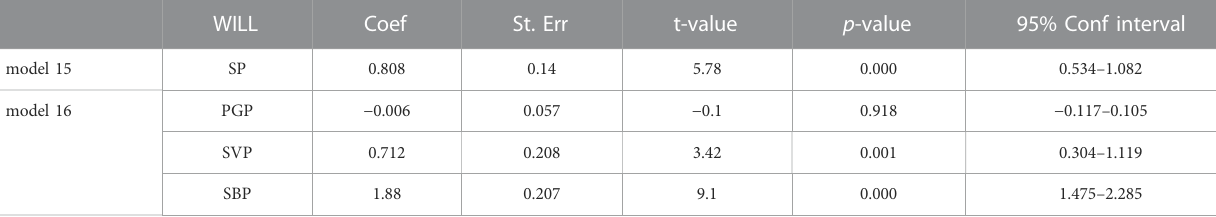
TABLE 9 Order-Probit regression results of the factors in fl uencing farmers ’ willingness to utilize